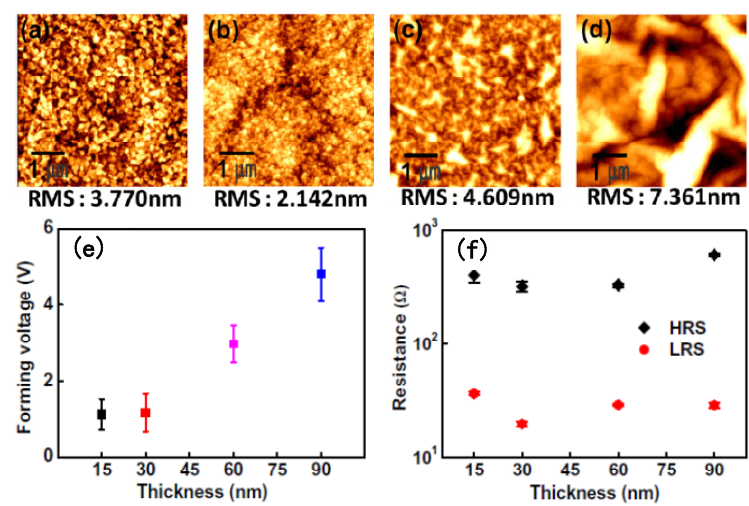
Figure 5. The surface roughness of GO after deposition on various bottom electrodes: ( a ) ITO, ( b ) Pt, ( c ) Al, and ( d ) Au. ( e ) GO film thickness dependence of forming voltage of Cu / GO / Pt memory cells. ( f ) High- and low-resistance states (HRS and LRS) of Cu / GO / Pt memory cells, plotted against the thickness of GO [132,133].